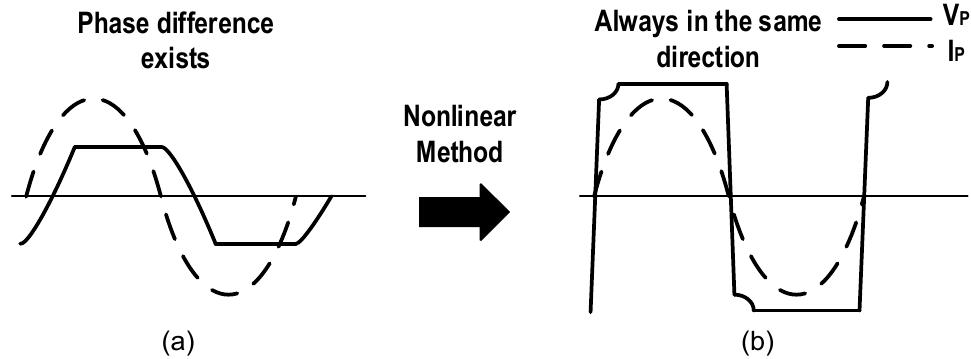
Figure 5. ( a ) Original waveforms of V P and I P , ( b ) waveforms of V P and I P after non-linear processing.